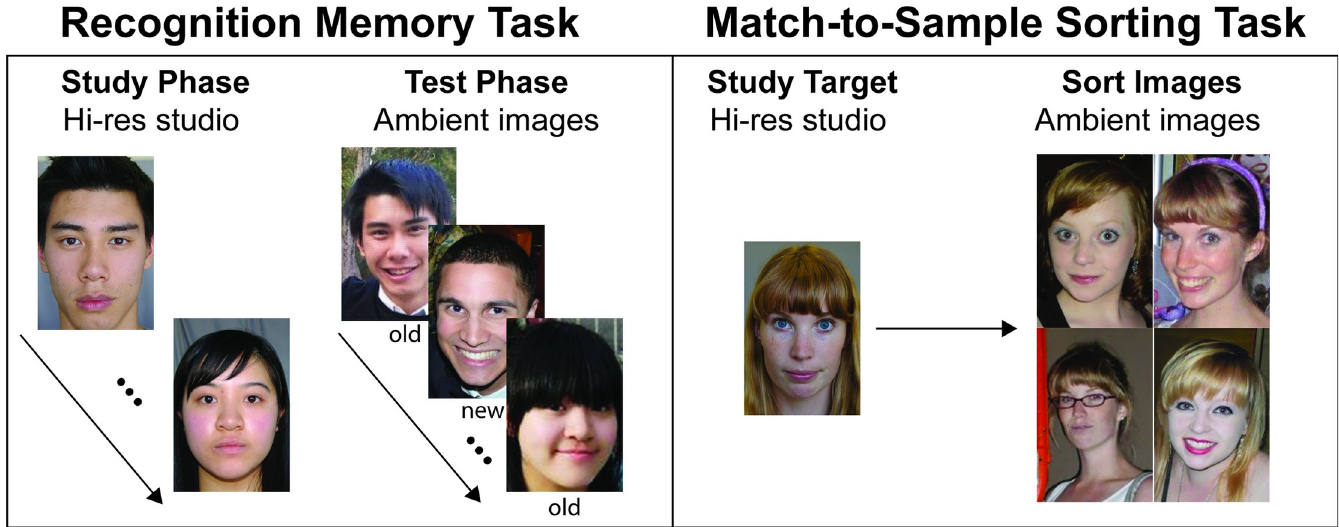
Fig 1. UNSW face test design. The UNSW Face Test contains two tasks. Left: In the recognition memory task participants study studio-quality target faces for 5 seconds each (Study Phase), and then make old/new recognition judgments on ambient test faces (Test Phase). Right: In the match-to-sample sorting task participants memorize a studio-quality target face for 5 seconds and then sort 4 ambient test images according to whether they are the target face. Scores on each task are summed for a maximum score of 120 and then expressed as a percentage.